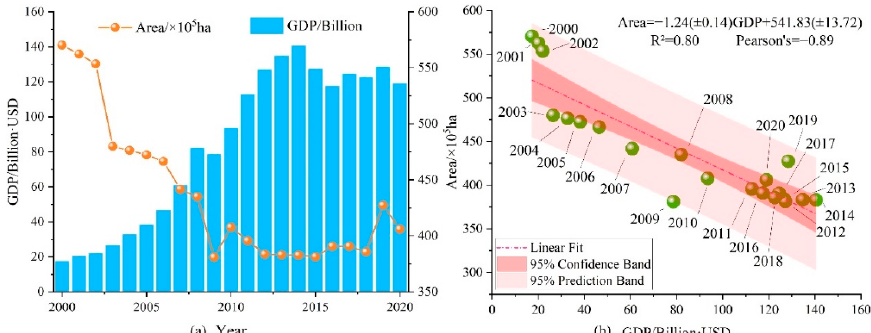
Figure 6. The changes in the area of water bodies and GDP in the ASB from 2000 to 2020 ( a ), and the linear relationship between water body area and GDP ( b ).